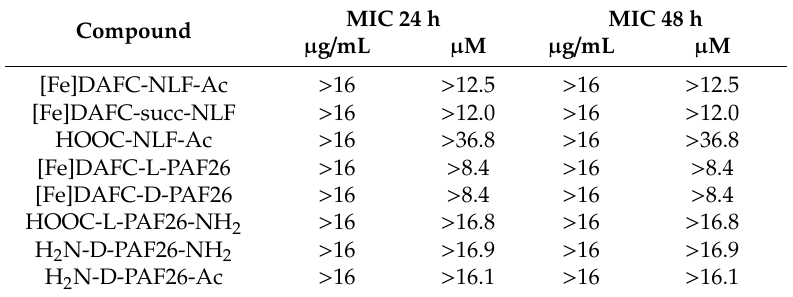
Table 2. Minimal inhibitory concentrations (MIC) of A. fumigatus incubated for 24 h and 48 h with antifungal conjugates at 37 ◦ C in Aspergillus min imal medium (AMM) . (Values from three biological